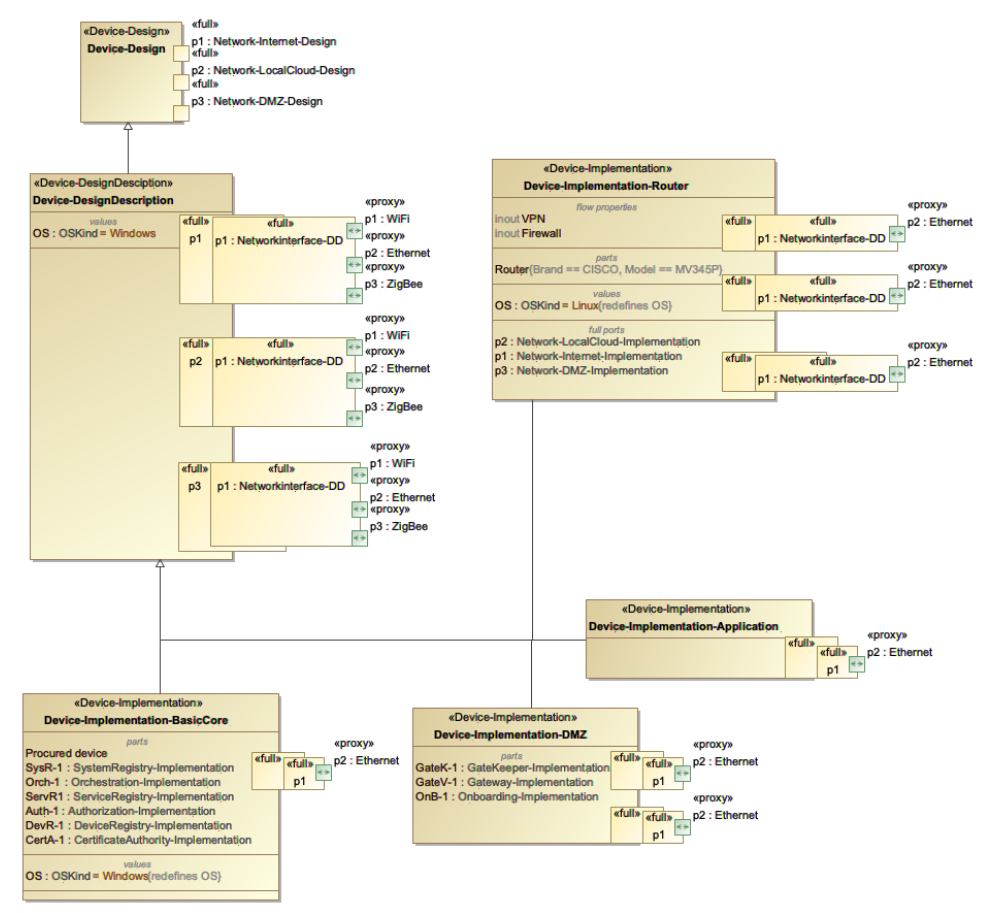
Figure 8. Black box, white box, and implementation models of the hardware devices with some spe- cific implementation examples indicating different device roles and the associated code